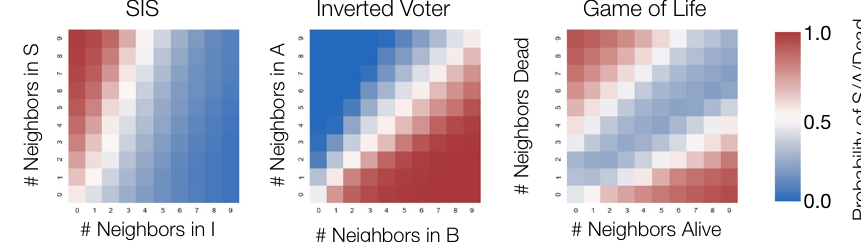
Fig. 6 Output of the prediction layer for a random node in the Watts-Strogatz network. We map neighborhood counting vectors to the probability of the node being instate S ( SIS ), A (InvVoter), or D (Game of